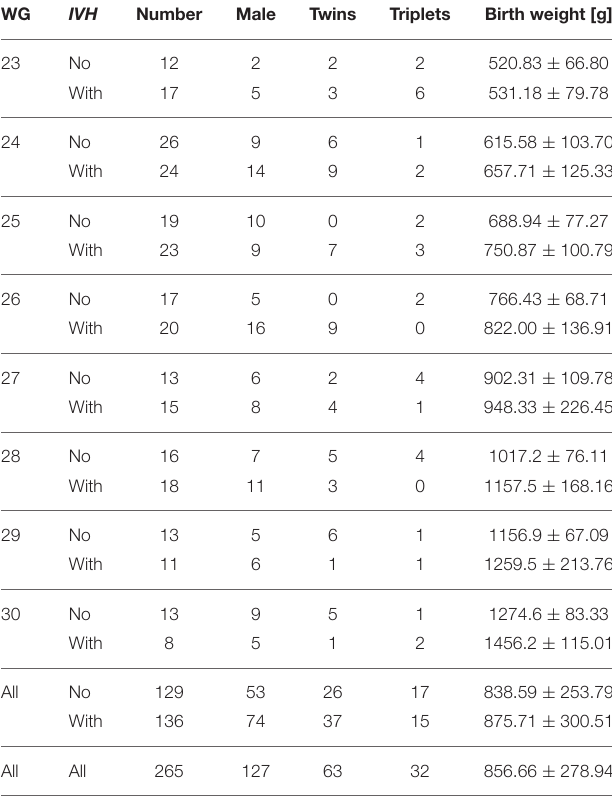
TABLE 1 | Obstetric characteristics of the control (no IVH ) and risk (with IVH ) groups. WG